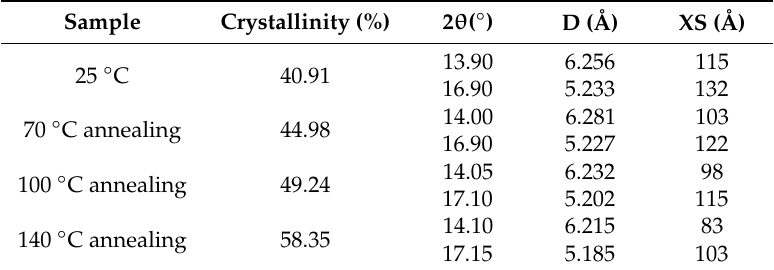
Figure 5. Electret properties of the annealed melt blown samples: ( a ) surface voltage decay after two months, ( b ) thermally stimulated discharge (TSD) spectra, ( c ) X-ray diffraction (XRD) pattern, and ( d ) schematic of piled charges at the crystalline surface. Table 2. Crystallinity of the samples with annealing